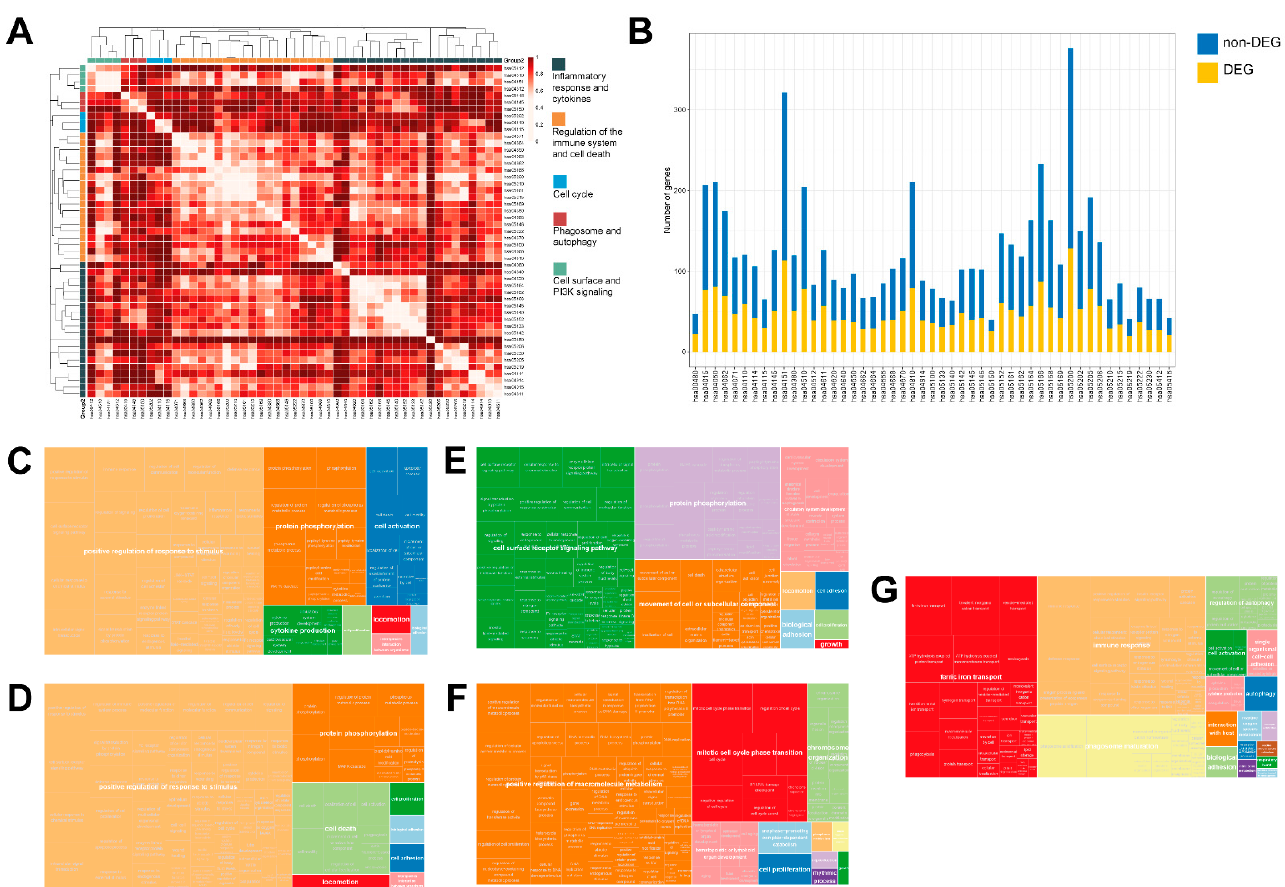
Figure 3. Superpathways summarizing the hallmarks of canine prostate cancer (PCa). ( A ) The forty-nine Kyoto Encyclopedia of Genes and Genomes (KEGG) pathways enriched among canine PCa differentially expressed genes (DEGs). Note that the analysis was performed based on the human homologs of the canine DEGs to take advantage of the better annotation available for human genes. The color of the cells in the heatmap visualizes the overlap coefficient-based distance between pairs of pathways; while 0 implies a 100% overlap between the gene members of the pathways, 1 implies 0%. The pathways were hierarchically clustered using the complete linkage algorithm based on a distance defined as 1 minus the overlap coefficient; ( B ) Stacked bar chart showing the number of gene members that are not differentially expressed (yellow) and DEGs (blue) in each of the 49 pathways enriched among canine PCa DEGs; ( C – G ) Superpathway treemaps: Summary of the Gene Ontology (GO) biological processes enriched in the five superpathways. Gene ontology (GOTERM_BP_FAT) enrichment analysis was performed on DEGs using the database for annotation, visualization and integrated Discovery (DAVID) [38], and clustered and displayed with Reduce + Visualize Gene ontology (REVIGO) [39]. The treemaps show the enriched biological processes and the box sizes represent the respective negative logarithm of the false discovery rate (FDR): ( C ) Inflammatory response and cytokines superpathway; ( D ) Regulation of the immune system and cell death superpathway; ( E ) Cell surface and PI3K signaling superpathway; ( F ) Cell cycle superpathway; ( G ) Phagosome and autophagy superpathway.